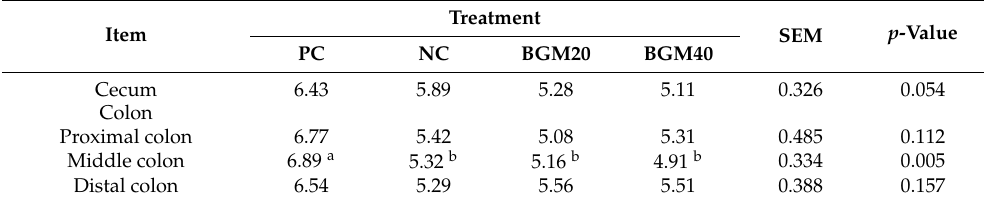
Table 8. Effect of dietary BGM with combined enzymes inclusion on hindgut pH of growing pigs 1